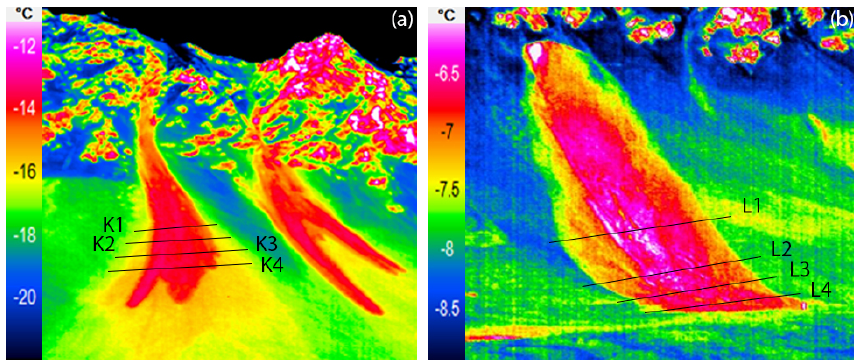
Figure 6. IRT camera images for avalanches (a) #1a and #1b and (b) #2. Note the different temperature scales amongst the avalanches. Black lines indicate positions of lateral snow temperature transects.